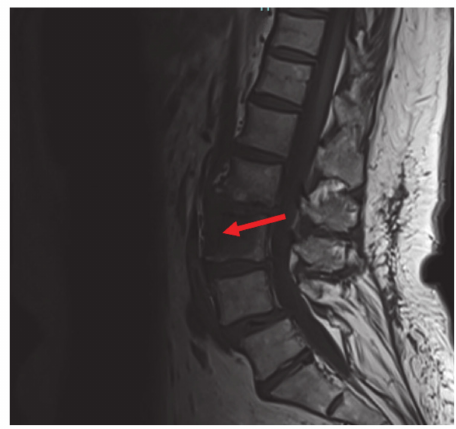
Figure 3. Magnetic Resonance Imaging (MRI) lumbar spine: L3 vertebral body metastasis (red arrow) without compression deformity or canal compromise. Not visualized, severe facet arthropathy with grade 1 anterolisthesis of L4 on